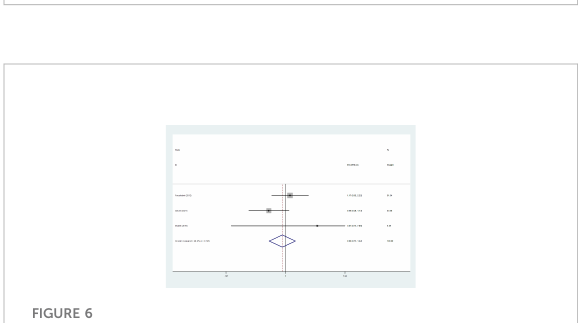
FIGURE 6 Forest plot of LRFS comparing MMBC and UFBC.